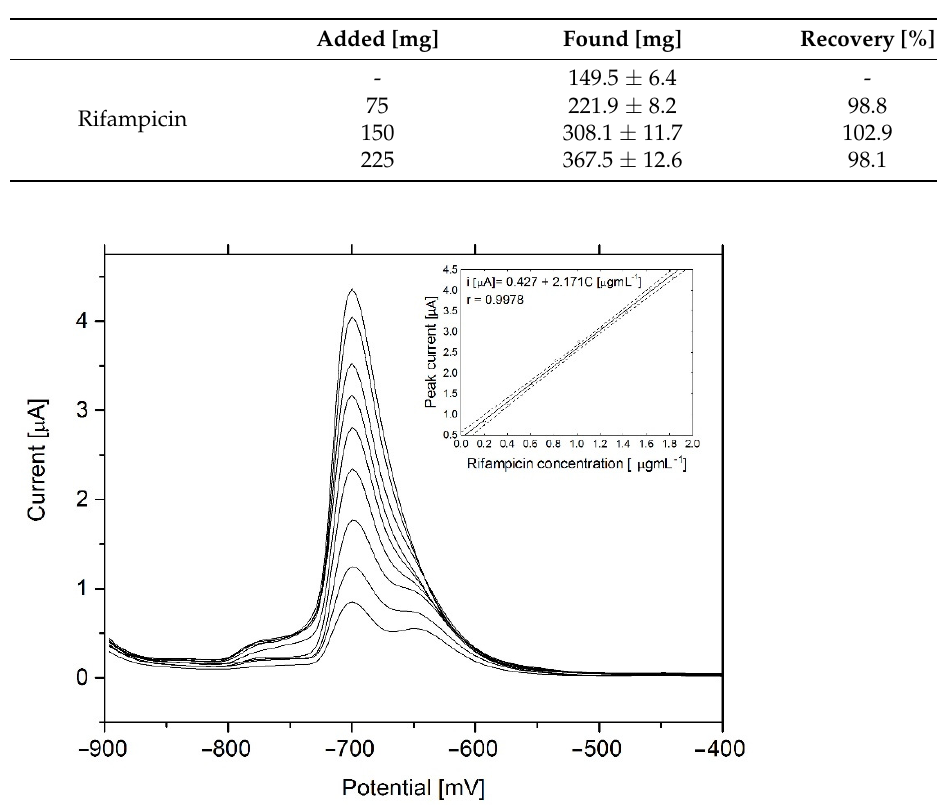
Table 2. Recovery of rifampicin determination in Rifamazid ® .